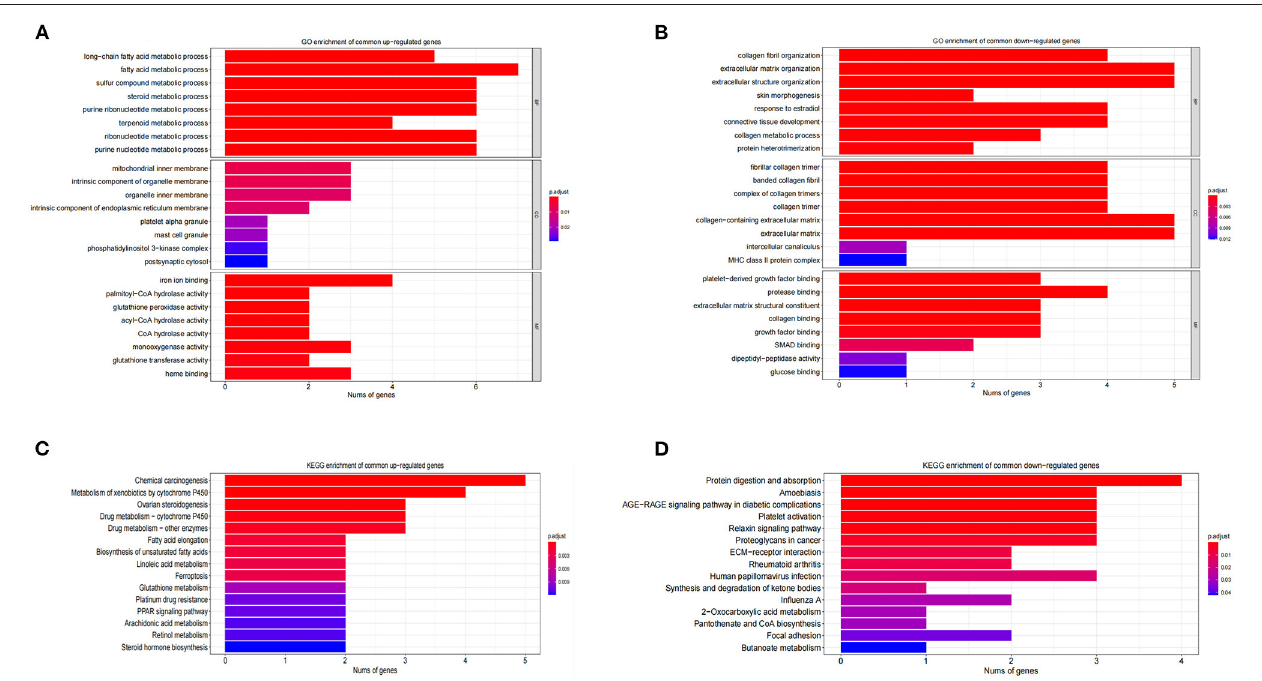
FIGURE 4 | GO and KEGG enrichment analysis of DCM in datasets GSE4745 and GSE6880. (A) The enriched GO terms of common differentially up-regulated genes; (B) The enriched GO terms of common differentially down-regulated genes; (C) KEGG pathway enrichment of common differentially up-regulated genes; (D) KEGG pathway enrichment of common differentially down-regulated genes; BP, biological process; CC, cellular component; MF, molecular function.